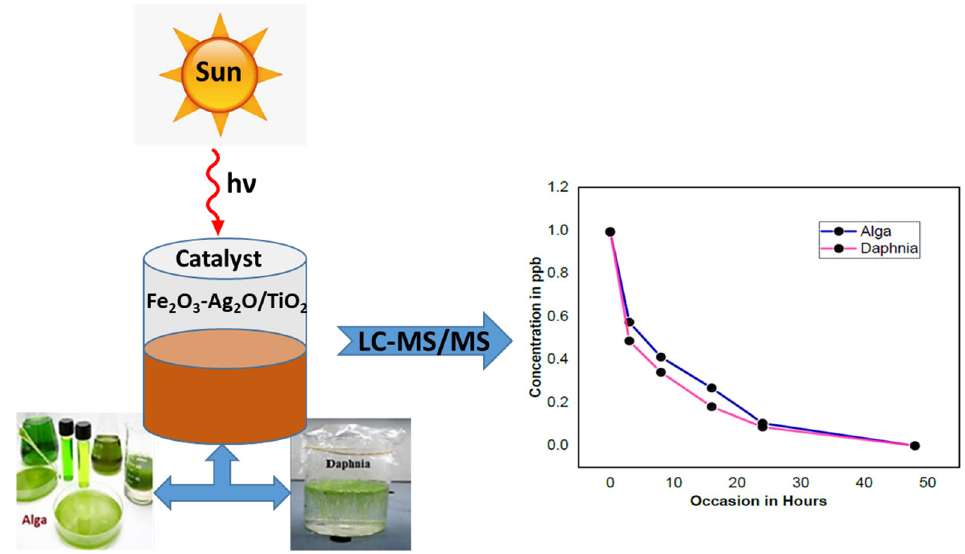
Figure 1. Schematic diagram of photocatalysis.